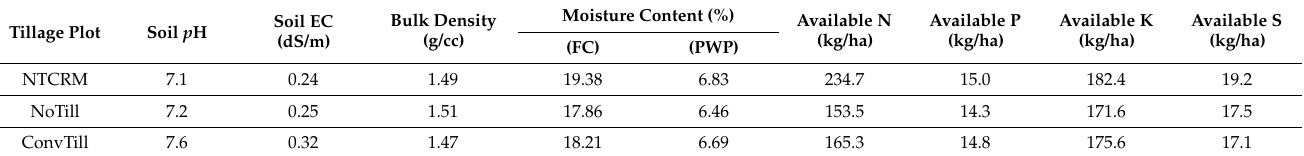
Table 4. Soil physicochemical properties of 0–15 cm depth at the start of the